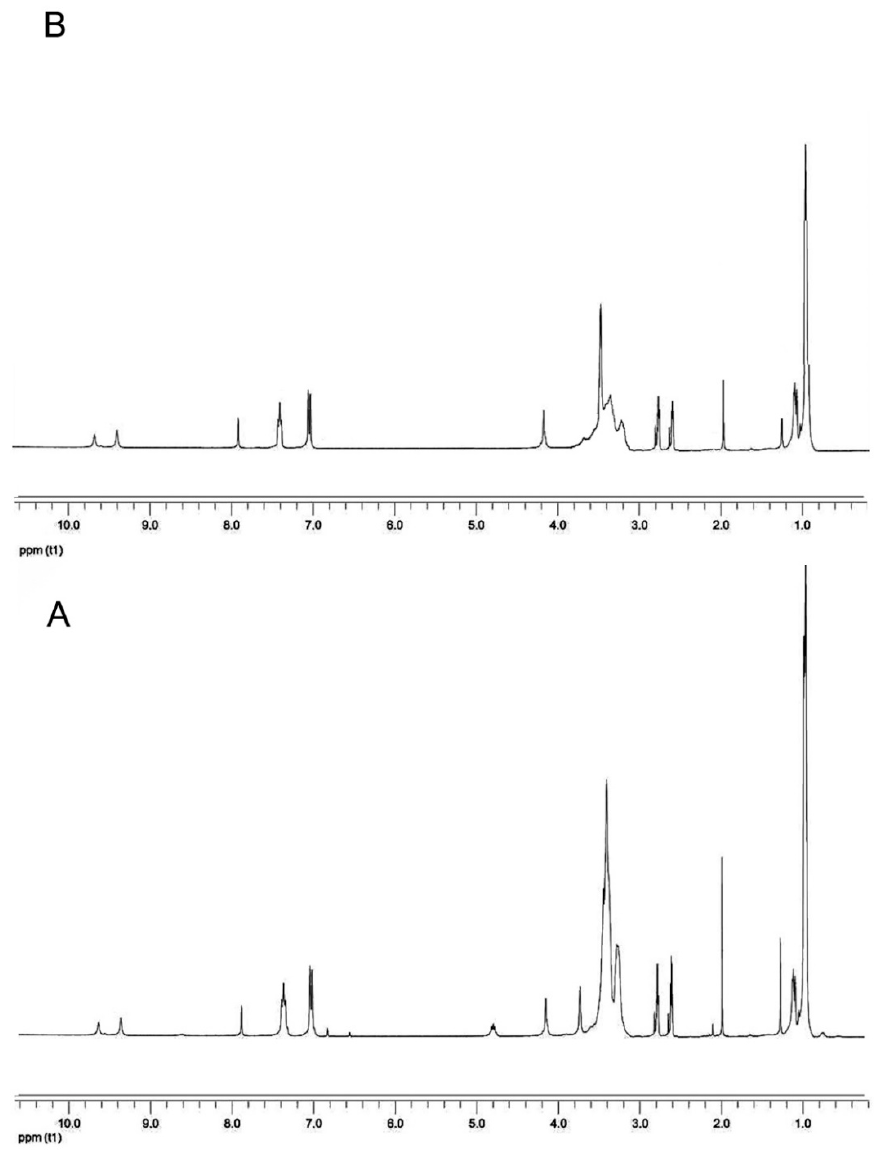
Figure 3. 1 H-NMR spectrum of PEUA ( A ) and PEUA-PEG obtained with a 5:1 PEG:PEUA molar ratio ( B Figure 3. 1 H ‐ NMR spectrum of PEUA ( A ) and PEUA ‐ PEG obtained with a 5:1 PEG:PEUA molar ratio ( B ).